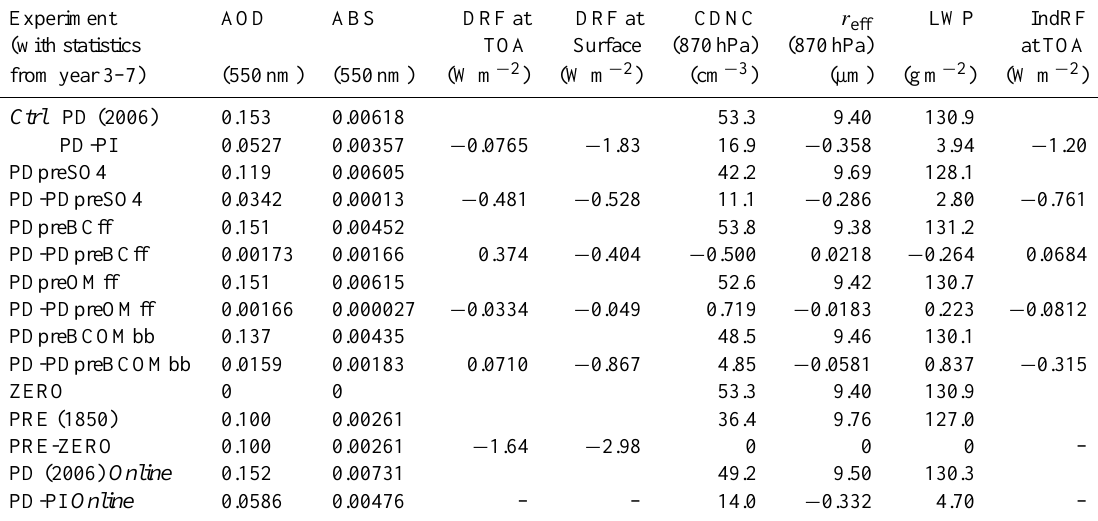
Table 4. Aerosol optical depth (AOD) and absorptive optical depth (ABS) at 550nm, top of the atmosphere direct radiative forcing (DRF), cloud droplet number concentrations (CDNC) and effective cloud droplet radii ( r eff ) at 870hPa, liquid water path (LWP), and indirect radiative forcing (IndRF) for a range of experiments. The generic notation PDpreXX denotes an experimental setup as for the reference Ctrl, with present-day (PD) emissions for year 2006, except for aerosol component XX where preindustrial (PI) emissions for year 1850 are applied. The difference PD-PDpreXX thus estimates the contribution of aerosol component XX to the changes from year 1850 to 2006. XX is SO 4 for sulphate, BCff for fossil fuel BC, OMff for fossil fuel organic matter, and BCOMbb for internally mixed BC and OM from biomass burning. The ZERO experiment is used to estimate the DRF of preindustrial aerosols relative to a clean atmosphere, by assuming AOD = 0. The data in the last row are not from the forcing experiments, but from the Online experiment (see Table